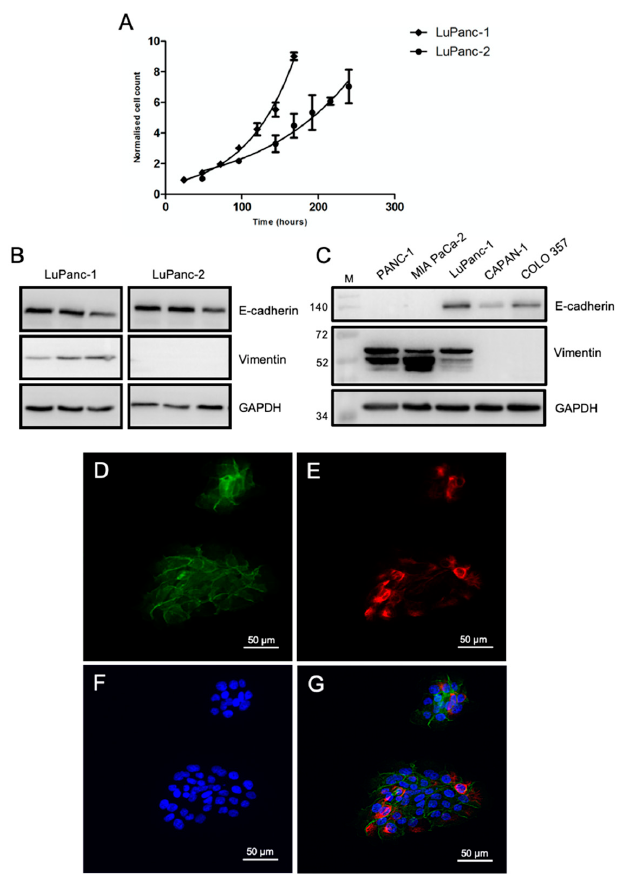
Figure 2. Molecular characterization of the LuPanc-1 and LuPanc-2 cell lines. ( A ) Growth curves for LuPanc-1 and LuPanc-2. ( B ) Crude proteinaceous extracts were prepared from both cell lines and subjected to the immunoblot analysis of E-cadherin and vimentin. ( C ) As the control, E-cadherin and vimentin expression in LuPanc-1 cells is shown in comparison to that in other PDAC-derived tumor cell lines of either the quasimesenchymal (PANC-1, MIA PaCa-2) or epithelial (CAPAN-1,